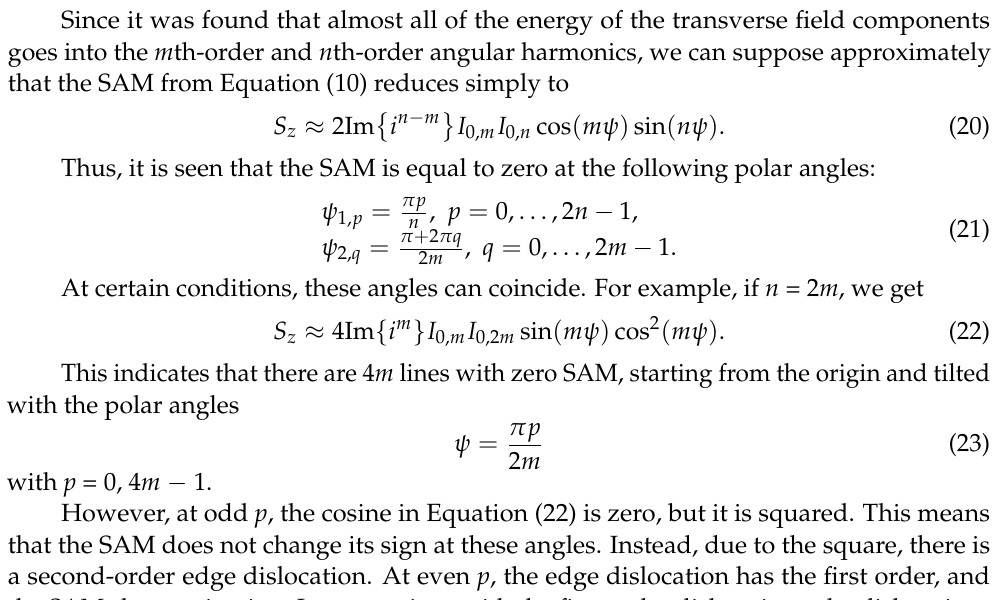
(Figure 4c,f,i) at the following parameters: wavelength λ = 532 nm, focal length of the lens f = 10 µ m, numerical aperture sin α = 0.95, amplitude apodization function is homogeneous, i.e., A ( θ ) ≡ 1. The SAM density distribution was computed directly by Equation (8) and